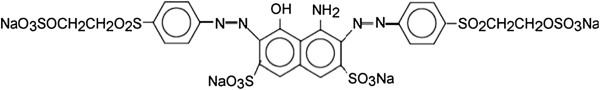
Chemical structure of the azo dye used in this study.